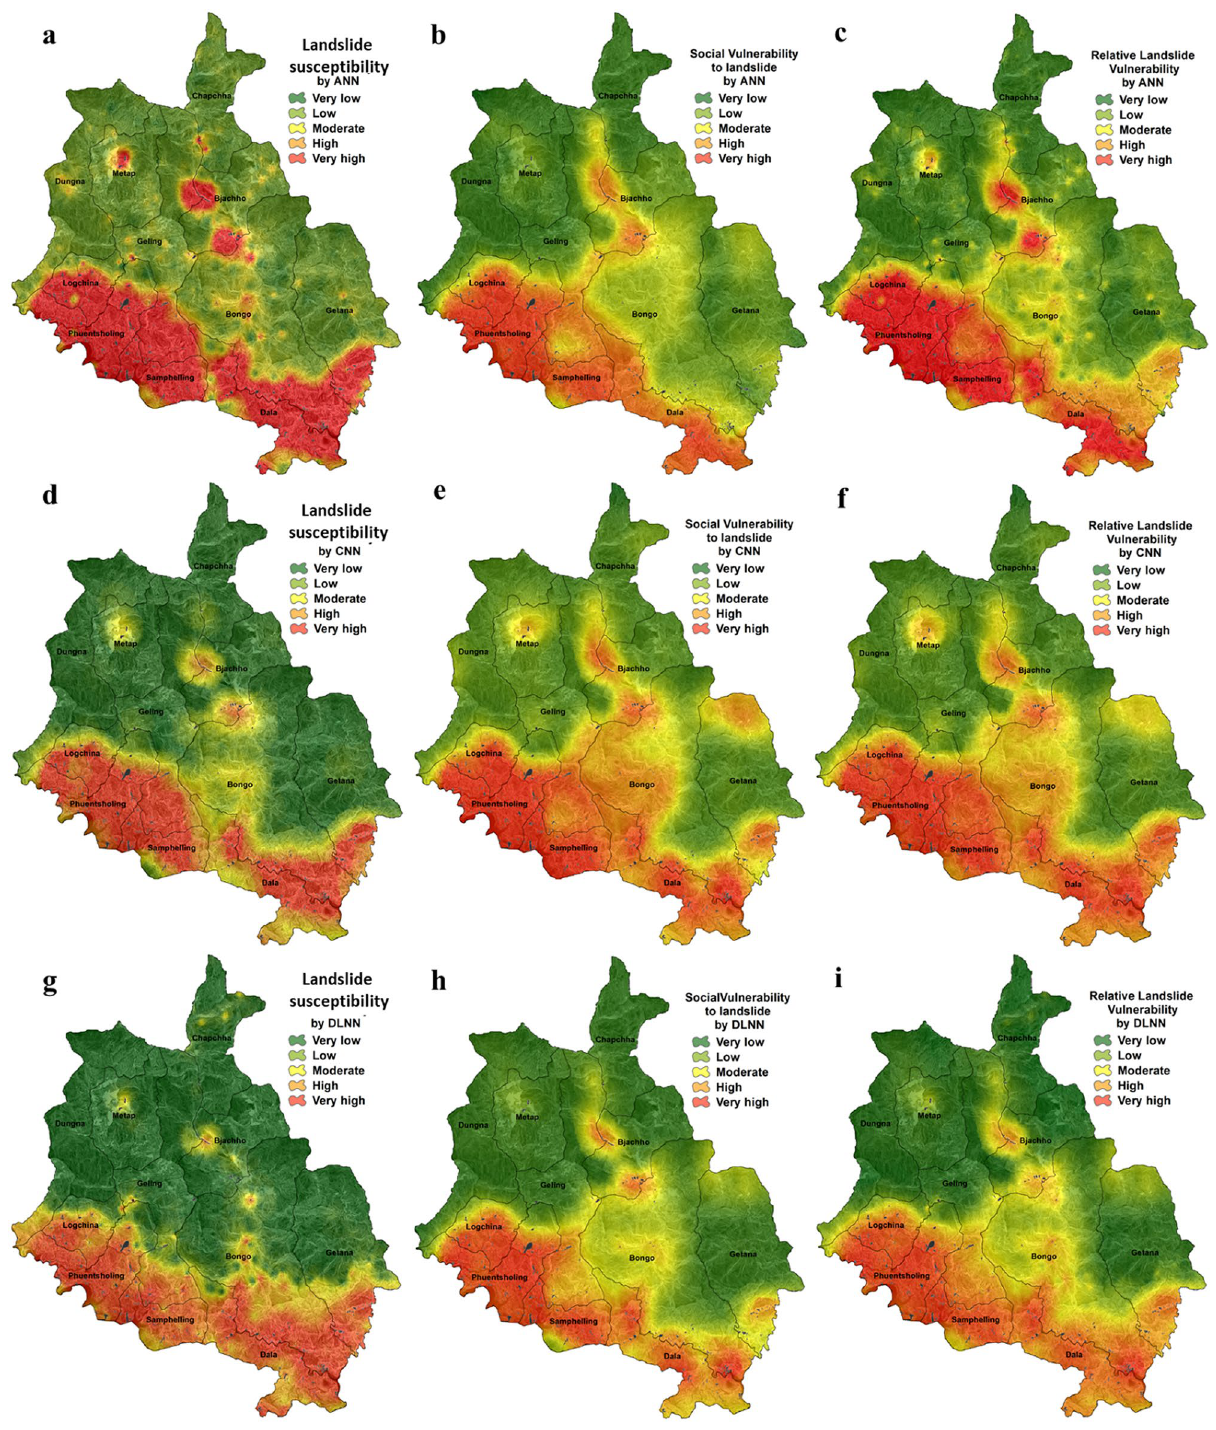
Figure 9. Physical, social and relative landslide vulnerability maps produced by: ( a ) ANN-LS, ( b ) ANN-SV, ( c ) ANN-RLV, ( d ) CNN-LS, ( e ) CNN-SV, ( f ) CNN-RLV, ( g ) DLNN-LS, ( h ) DLNN-SV and ( i ).